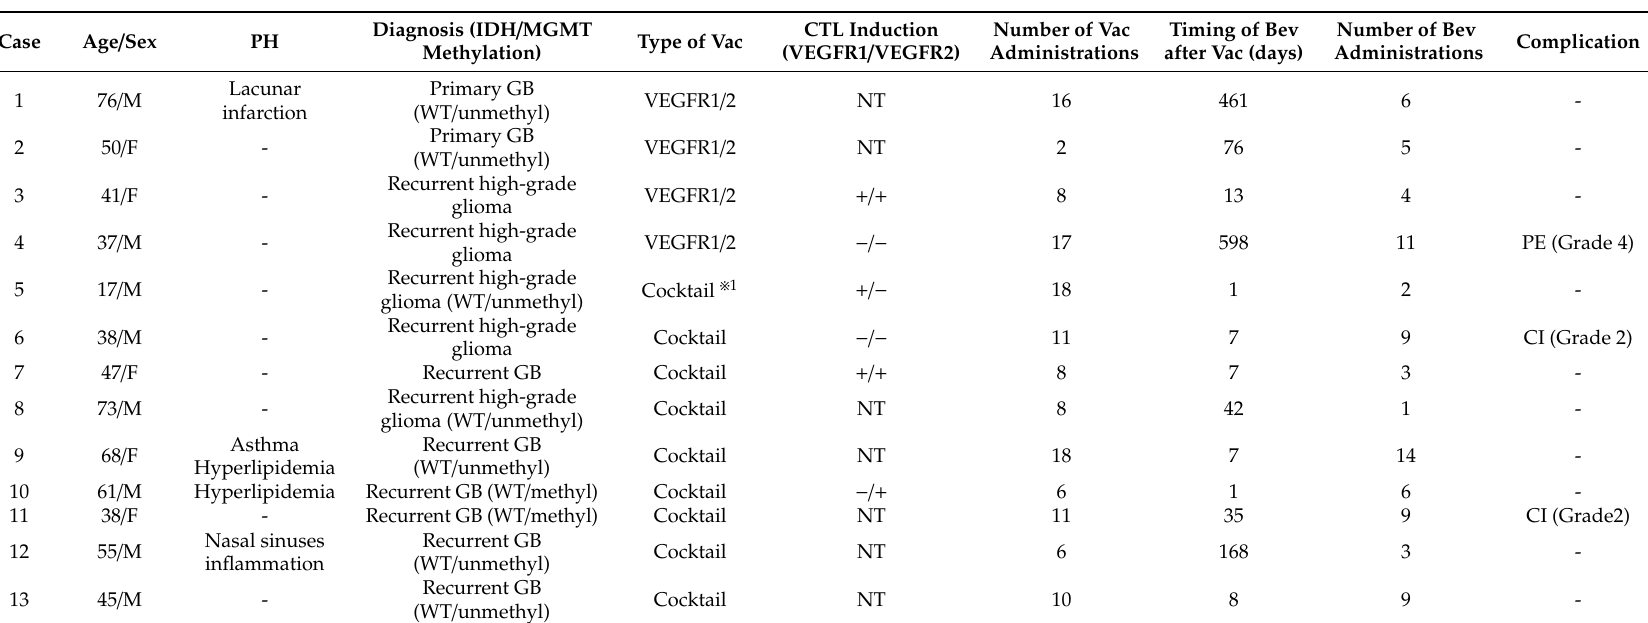
Table 2. Adverse event profile of patients treated with Bev after VEGFRs peptide vaccination (Vac + Bev